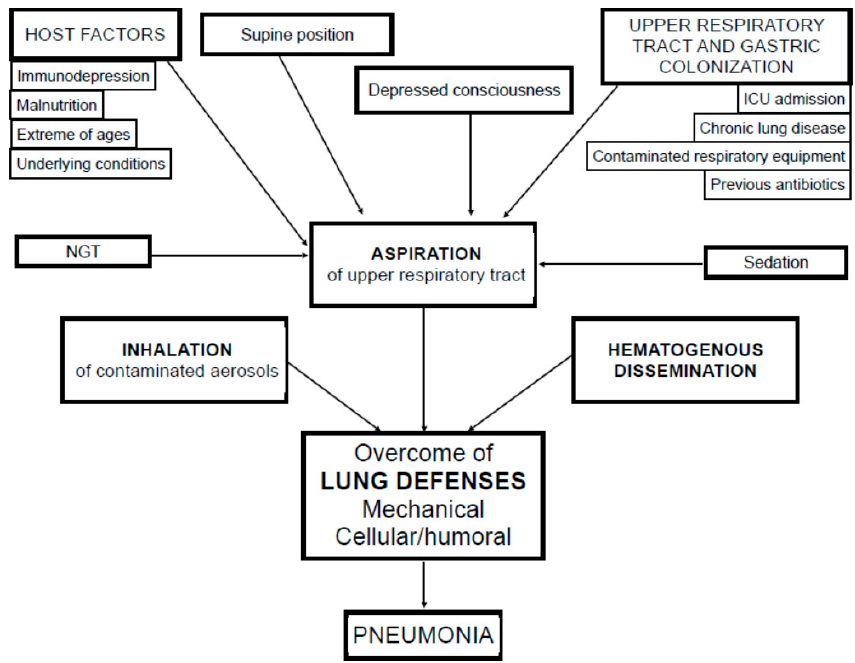
Figure 2. Pathogenesis. ICU intensive care unit; NGT nasogastric tube.